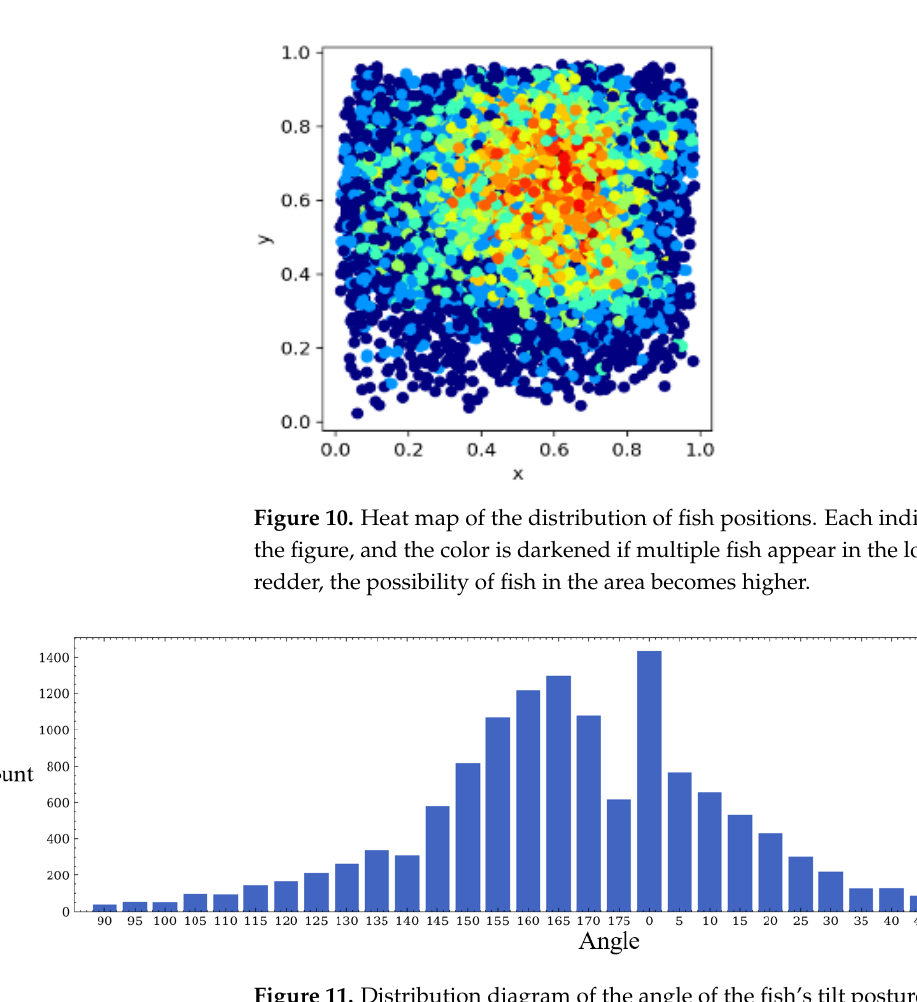
Figure 11. Distribution diagram of the angle of the fish’s tilt posture.